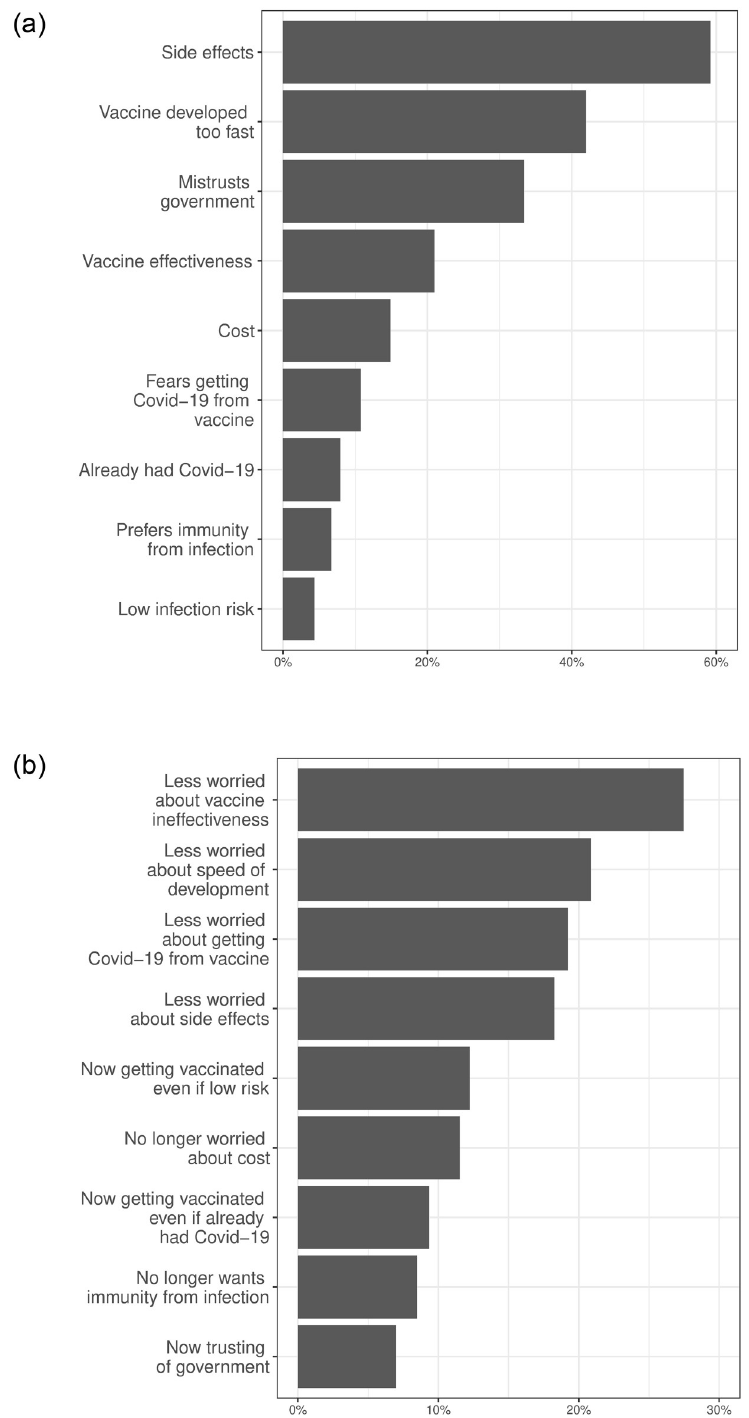
Fig 3. Reasons for initial vaccine hesitancy and response to vaccine information treatments. Panel (a) reports the percentage of hesitant respondents that chose each reason for hesitancy from a multi-response list. Panel Panel (b) reports the percentage of respondents that received a vaccine information treatment that chose each reason when asked how the vaccine information affected their concerns about COVID-19 vaccines. The exact questions and responses are shown in S18